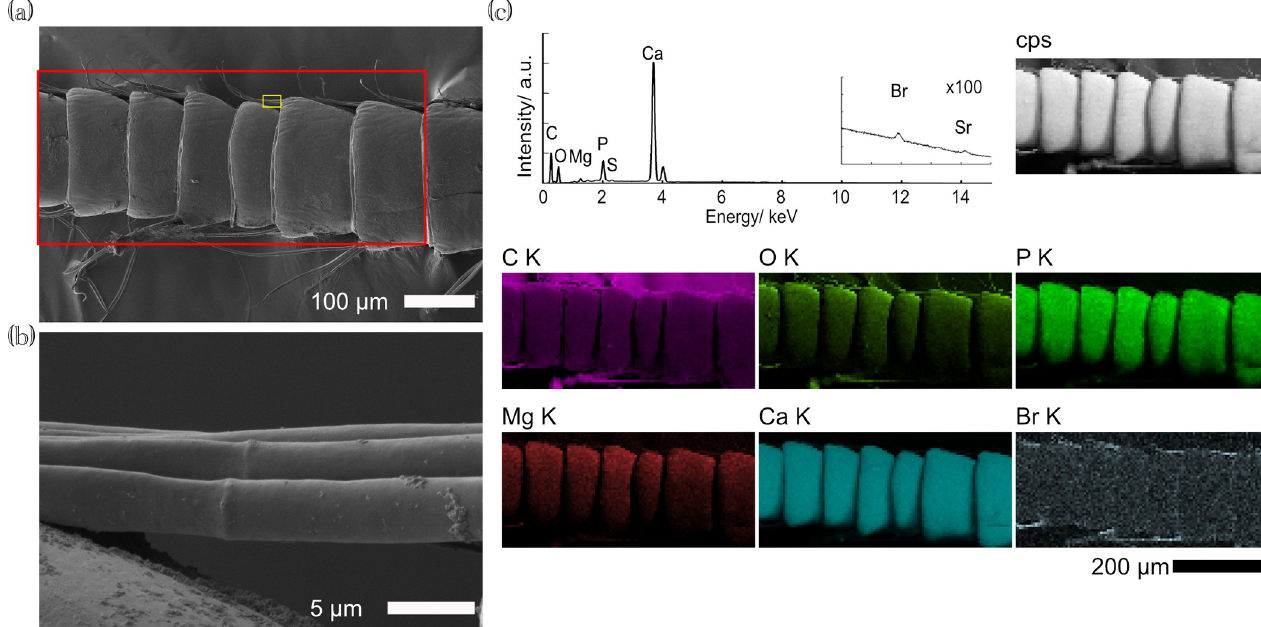
Fig 7. SEM/EDS images of an antenna of Hirondellea gigas . a) Low-magnification SEM image. b) Magnified image of the yellow rectangle in part (a). c) EDS elemental mapping and sum spectrum of the red rectangle in part (a).